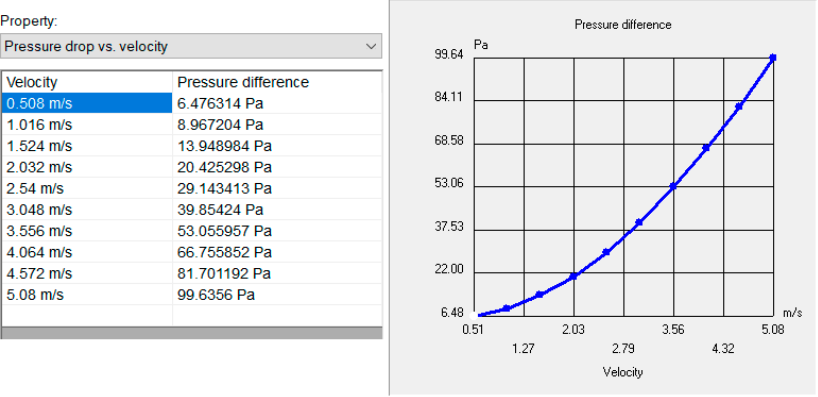
Figure 3. Dependence of pressure difference Δ P (Pa) on the flow rate of the liquid V (m/s). For the 2nd model, an additional metal mesh in front of the nozzles is modeled as well as an isotropic porous body. The dependence of the pressure drop Δ P (Pa) on the fluid flow rate V (m/s), for the case under consideration, is shown in Figure 4.